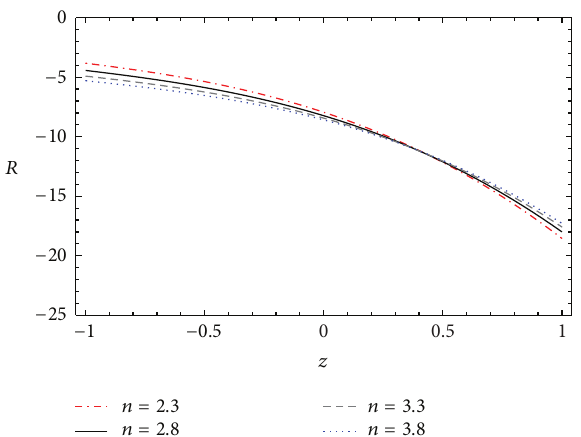
Figure 1: Reconstructed 𝑓(𝑅) for NADE with 0 ⩽ 𝑧 ⩽ 10 .